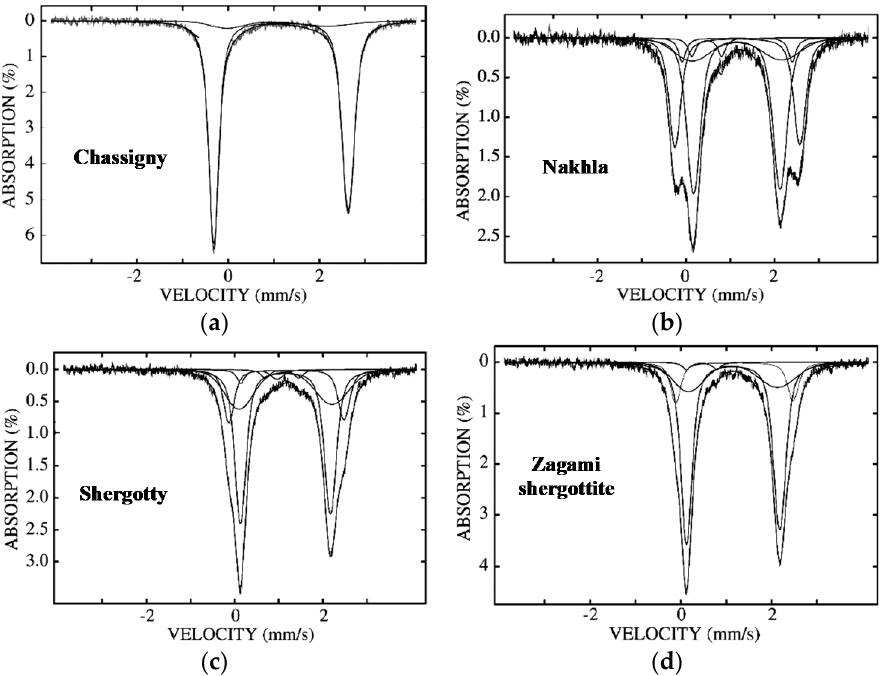
Figure 11. Room temperature Mössbauer spectra of selected SNC meteorites (bulk material): Chassigny ( a ), Nakhla ( b ), Shergotty ( c ), and Zagami shergottite ( d ). Indicated components are the results of the fits. Adapted from [28].